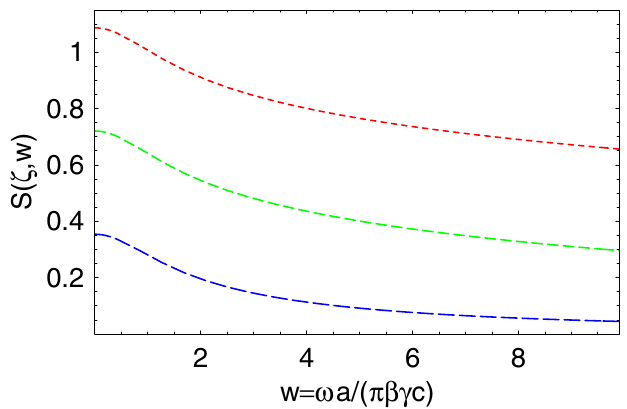
FIG. 6. (Color) The same versus w (cid:5) (cid:10)a=(cid:5) for three different beam sizes (cid:14)a , (cid:14) (cid:5) 0 : 001 ; 0 : 01 ; 0 : 1 (short-dashed, dashed, and long-dashed curves).